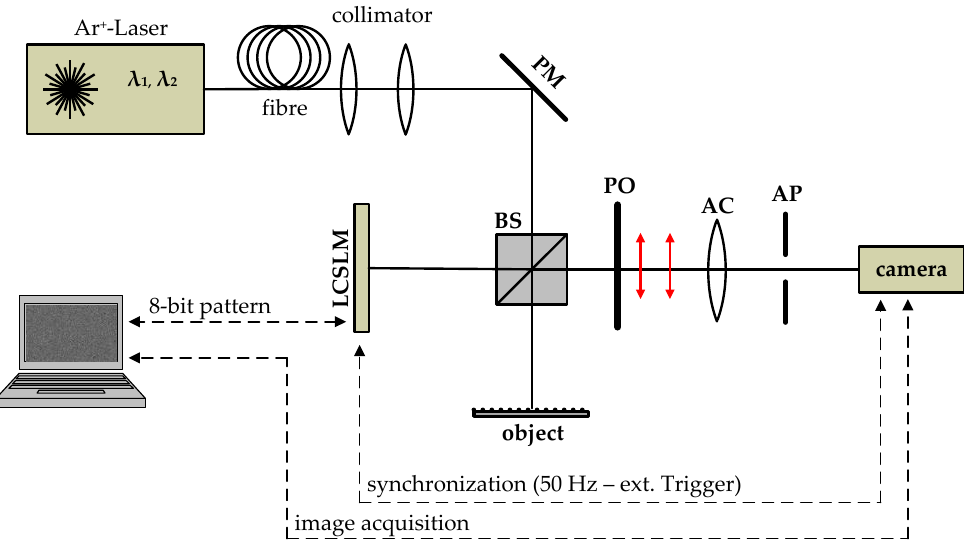
Figure 2. Experimental setup. PM: plane mirror; BS: beam splitter; PO: polariser; AC: achromatic lens; and AP: aperture.